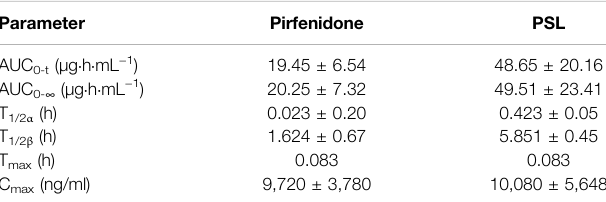
TABLE 2 | Pharmacokinetic parameters of pirfenidone and PSLs in rats injected via the tail vein (4 mgkg − 1 ) ( n = 6). Parameter